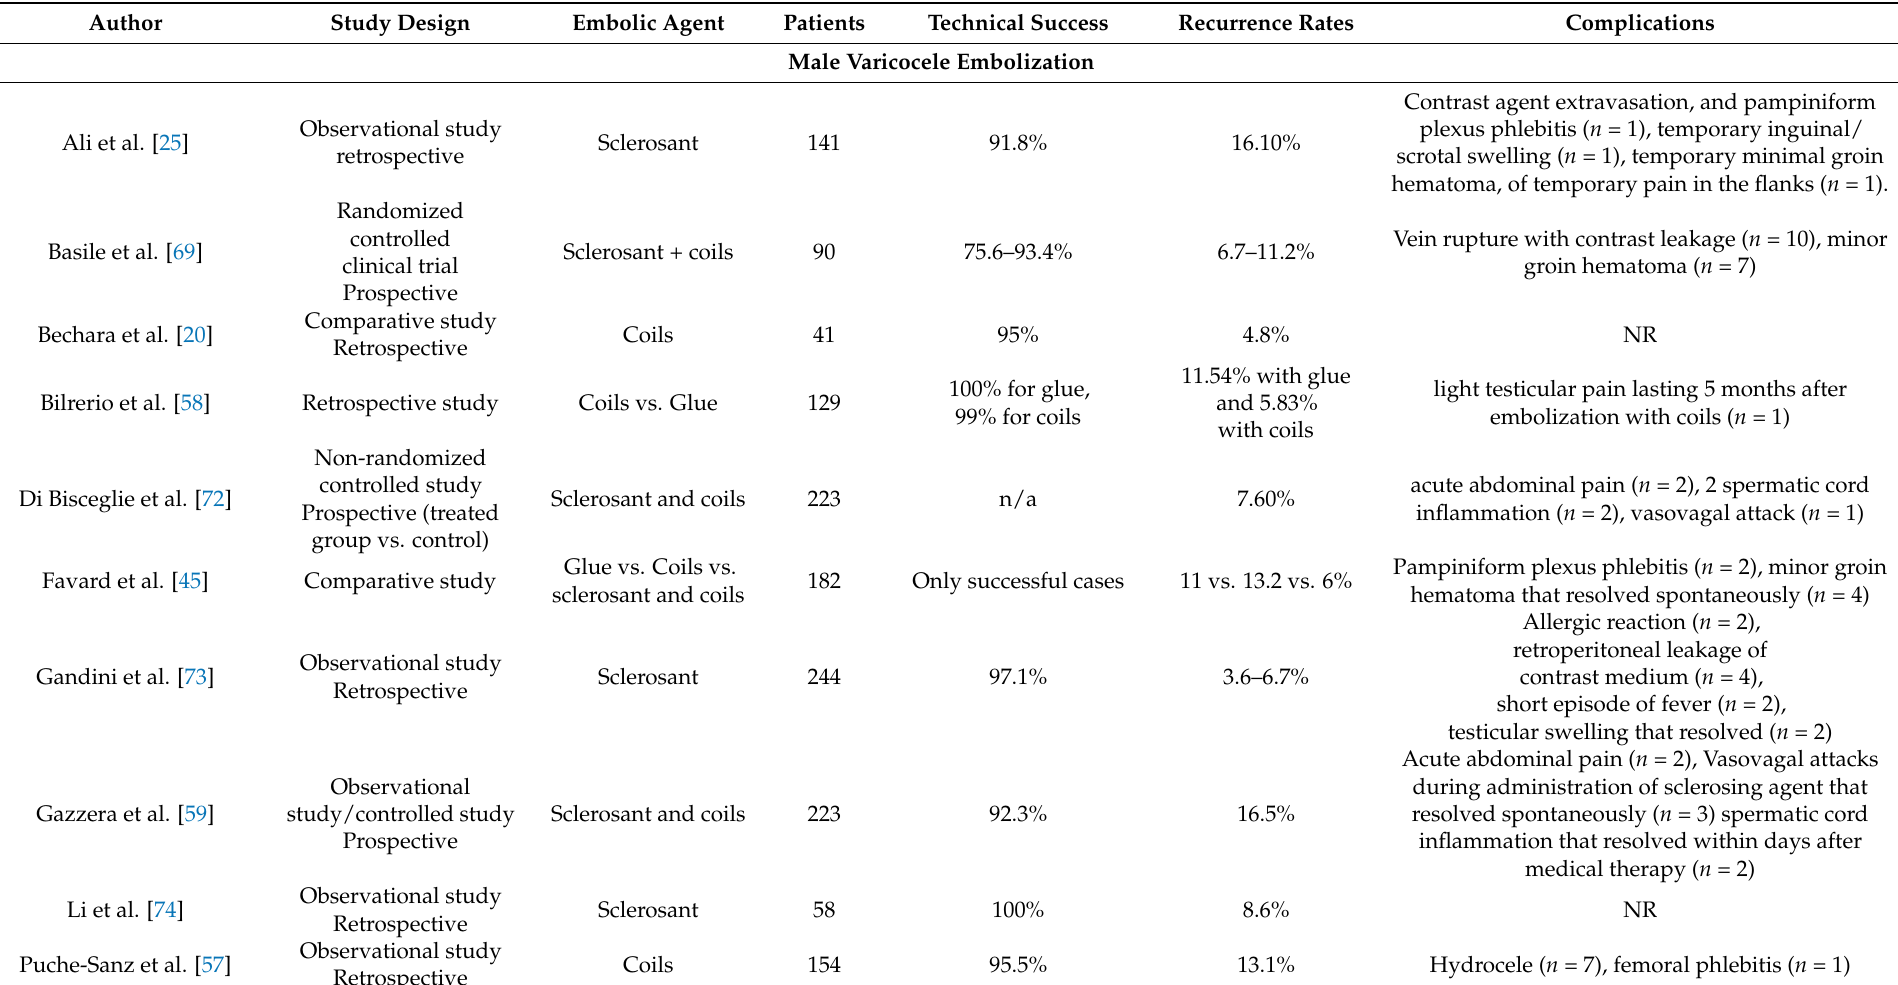
Table 2. This table summarizes the publications taken into consideration, the embolic materials used, the technical success rate, the recurrence rate and complications for male